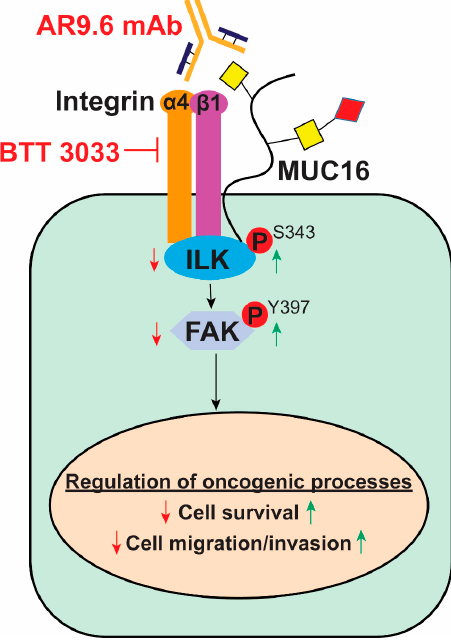
Figure 6. The proposed model for truncated O-glycan-containing MUC16 facilitates α 4 β 1 integrin signaling. Interaction between Tn/STn-MUC16 and the α 4 β 1 integrin complex facilitates activation of the integrin-linked kinase (ILK) and focal adhesion kinase (FAK) axis to increase migratory behavior in PDAC (indicated by green arrows). Blocking the integrin signaling using the BTT 3033 inhibitor or MUC16 signaling using the monoclonal antibody, AR9.6, dampens the ILK-FAK cascade and decreases cell migration (indicated by red